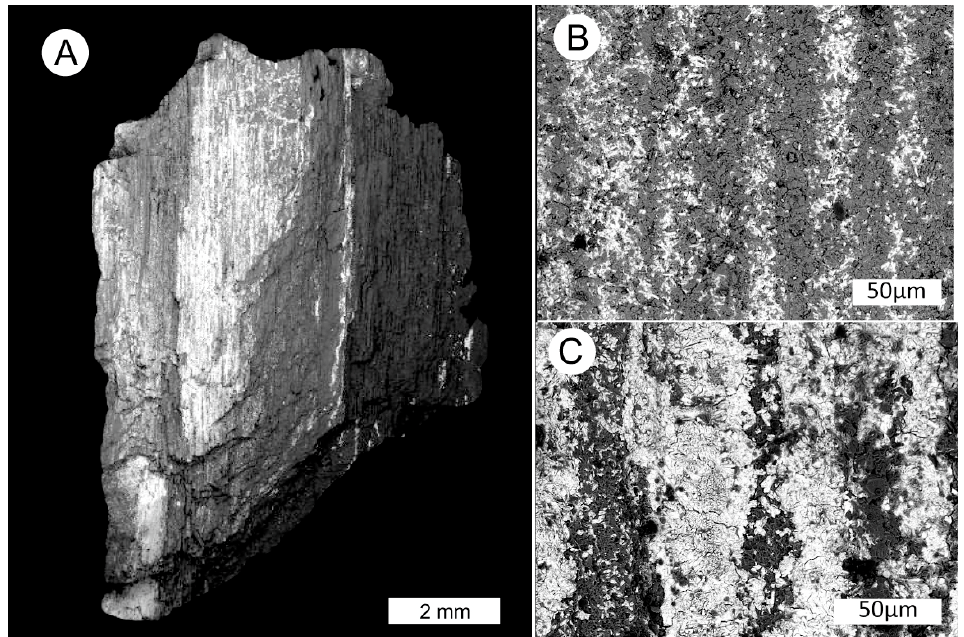
Figure 9. SEM BSE images. ( A ). Coffinite is revealed as bright white zones in the silicified wood. ( B) . Coffinite in a region of relatively low uranium mineralization, longitudinal view of silicified wood. ( C ) Coffinite occupying cell lumina, and as fine disseminations in silicified cell walls in a zone of relatively high uranium abundance.